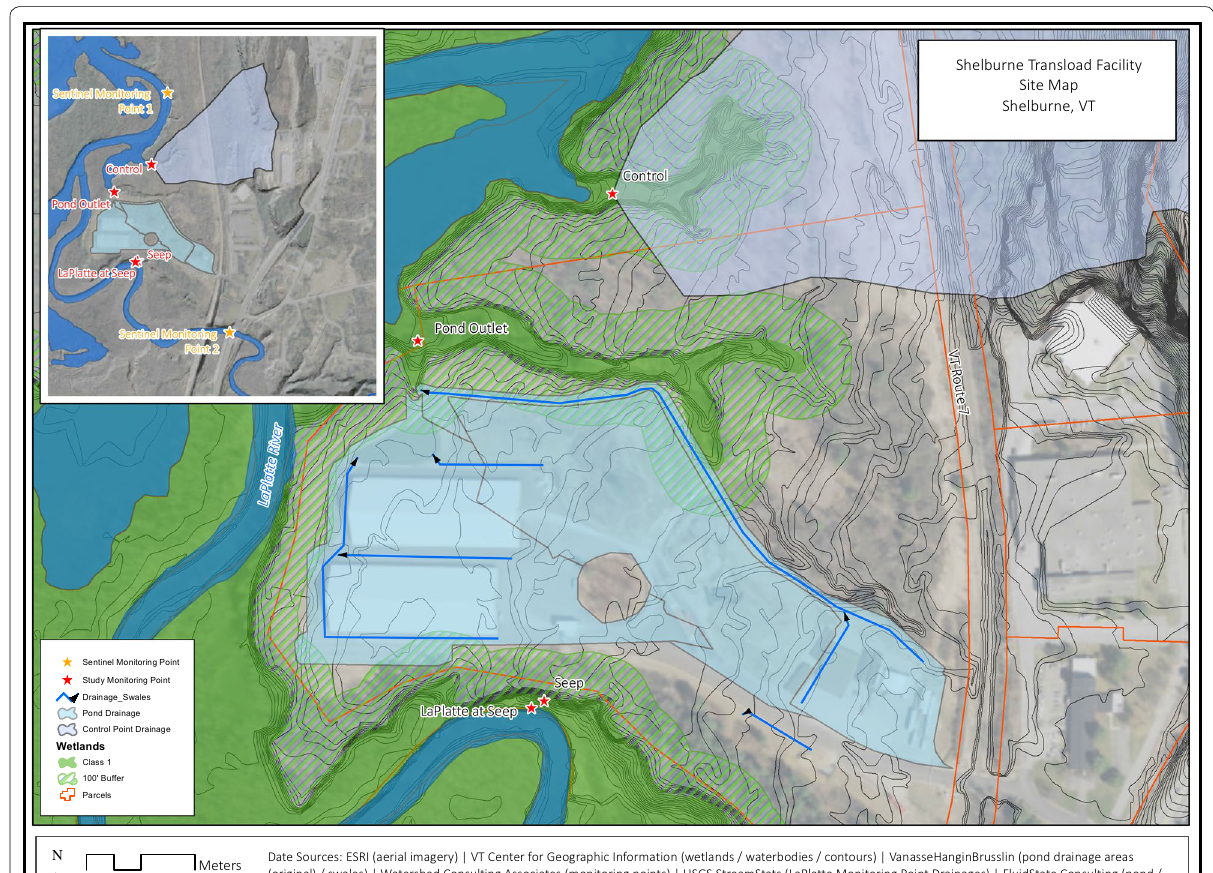
Fig. 2 Shelburne transload facility site and drainage area map for “Pond Outlet” and “Control” monitoring